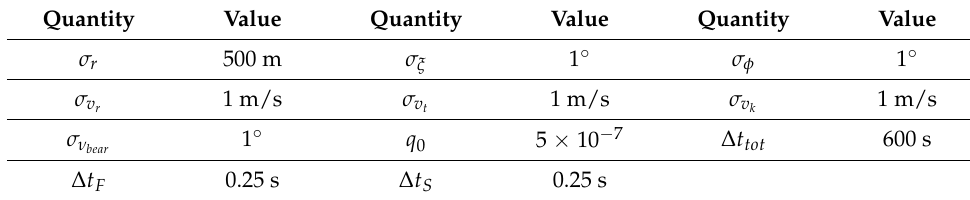
Table 1. Simulation parameters.